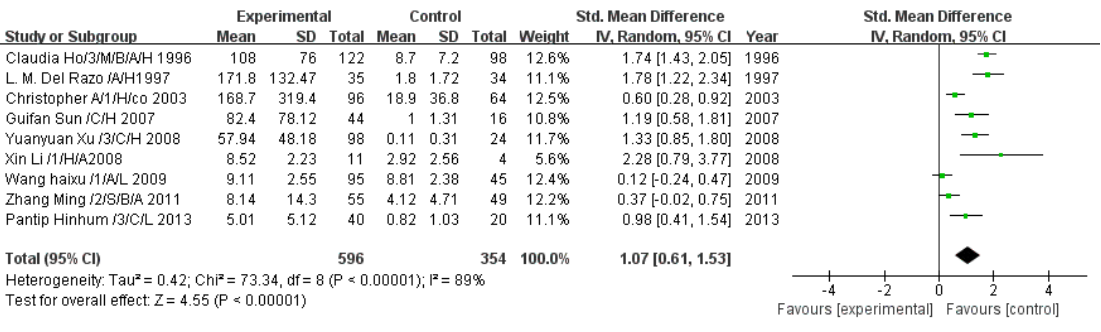
Figure 3. Effect of arsenic exposure on inorganic arsenic (iAs) concentration in urine. Std., standardized; SD, standard deviation; IV, independent variable; CI, confidence interval.